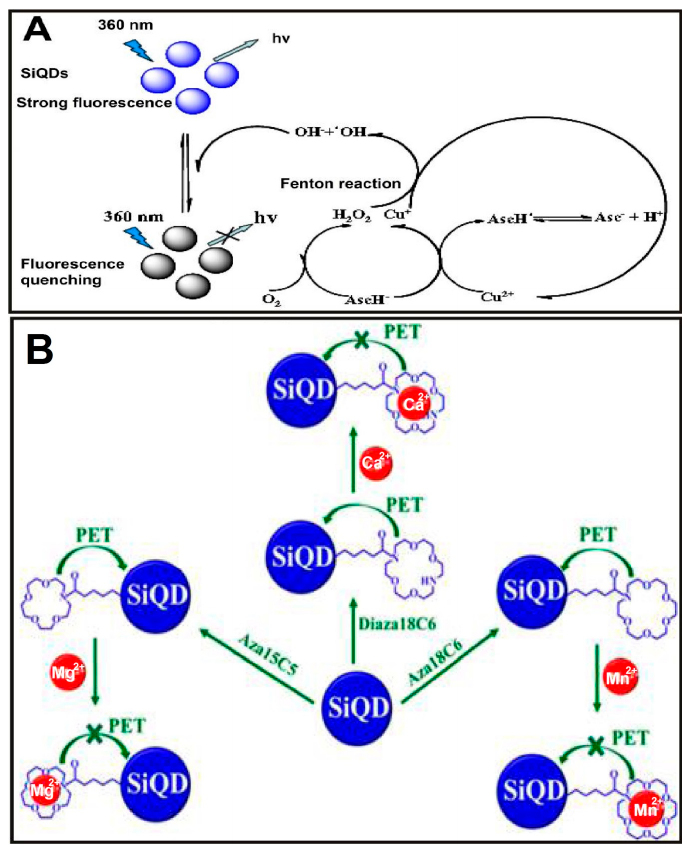
Figure 4. ( A ) Illustration of the strategy for the detection of Cu 2+ based on label-free silicon quantum dots (SiQDs) and Fenton reaction. Reproduced with permission from [56]. Copyright 2014, Elsevier. ( B ) Schematic representation for the PET process and subsequent suppression of photoinduced electron transfer (PET) between the aza-crown ethers’ moiety and SiQDs in the absence and presence of metal ions. Reproduced with permission from [57]. Copyright 2016, American Chemical Society.